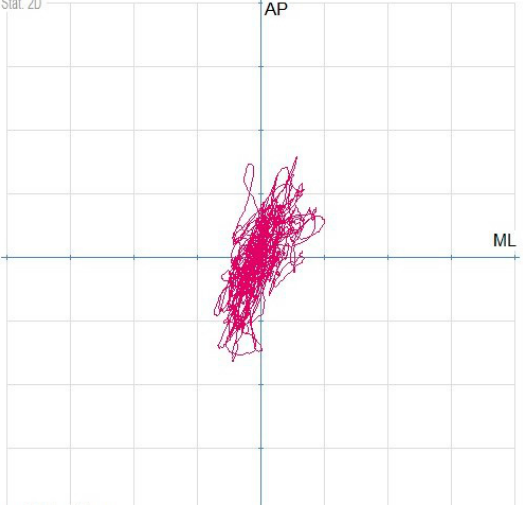
Figure 3. Diagram showing path length sample for COP during EO H test.